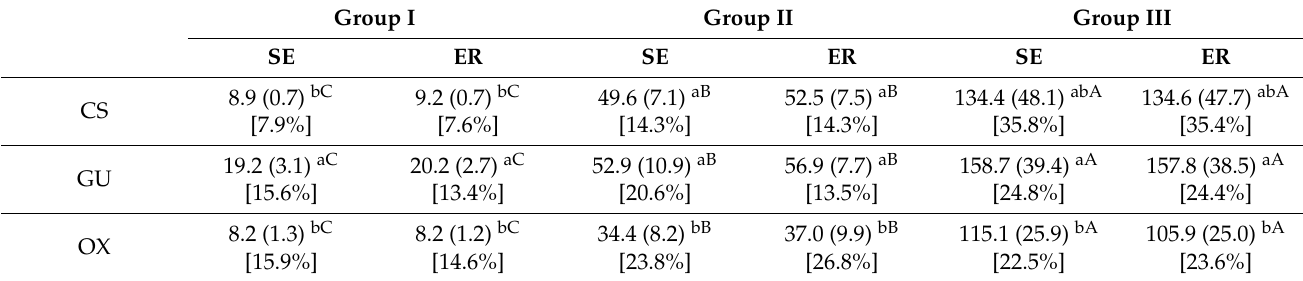
n = 12, mean (SD) in µ m. Same lower-case letters in vertical columns indicate no difference at 5% significance level. Same capital letters in horizontal rows indicate no difference at 5% significance level. Values in parentheses indicate standard deviation. Percentage values in brackets indicate coefficient of